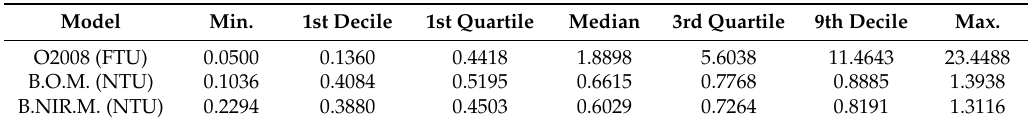
Table 3. Main quantile values of turbidity estimations by the O2008 model, the B.O.M. and the B.NIR.M. (see Sections 3.1 and 3.3) in the Voh-Kon é -Pouembout lagoon area on 21 April 2014.